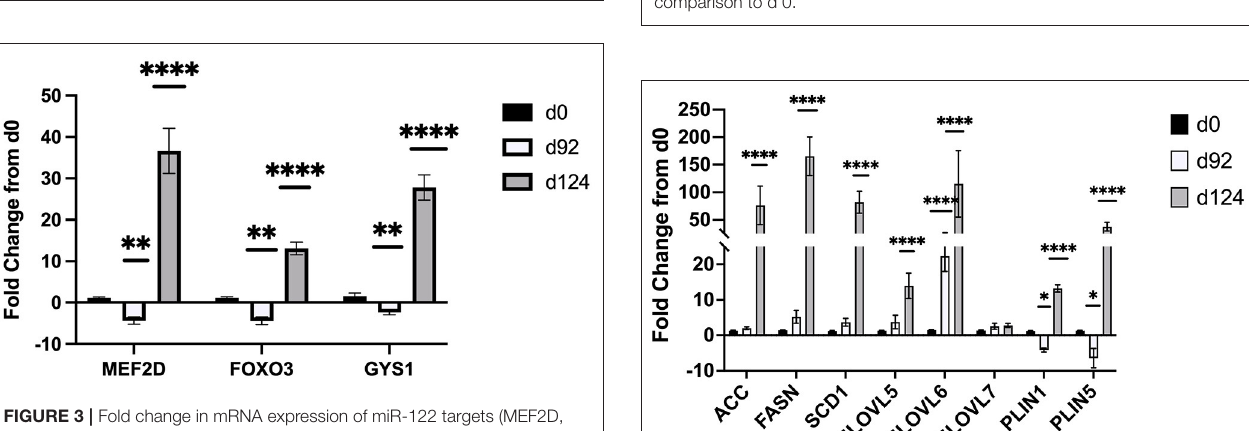
FIGURE 2 | Fold change in miR-122 expression of skeletal muscle biopsies ( n = 4/time) at d 92 and d 124 on concentrates compared to d0. Differences are noted (* P < 0.05; ** P < 0.01; *** P < 0.001; **** P < 0.0001) in comparison to d 0.